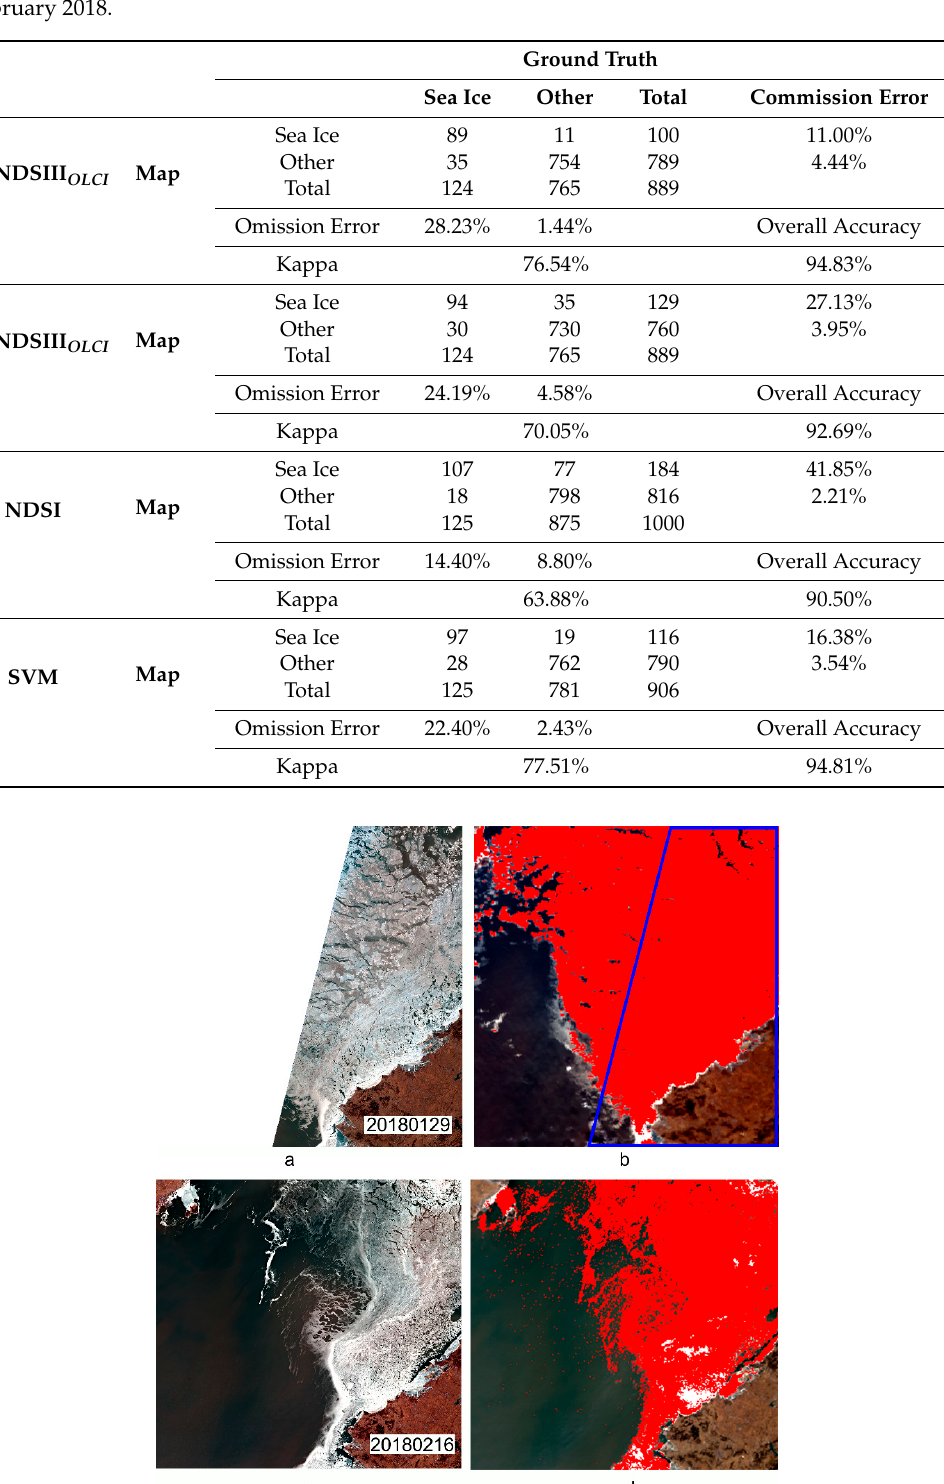
Table 2. Contingency table for accuracy validation of sea ice detection based on di ff erent methods on 1